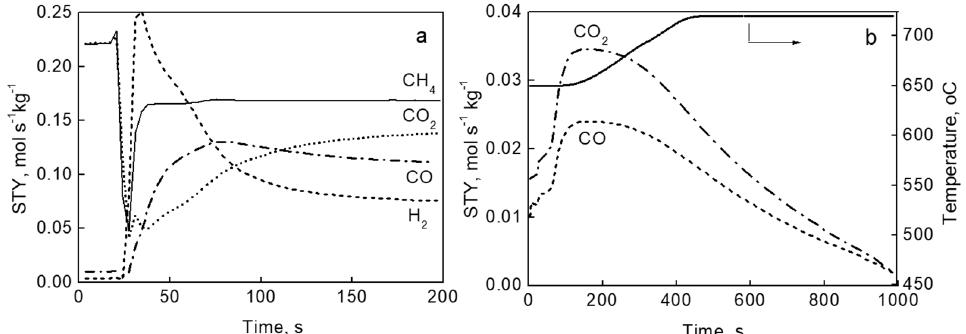
Figure 17. Space-time yield vs. time-on-stream for combined CO 2 capture and Fe 3 O 4 reduction over a NiO/Fe 2 O 3 –CeO 2 and CaO-Al 2 O 3 (1:5) mix. ( a ) CaO carbonation and Fe 3 O 4 reduction with CH 4 + CO 2 (1:1) at 650 °C, and ( b ) CaCO 3 decarbonation and CO production by iron and carbon oxidation by CO 2 . Temperature rise from 650 to 720 °C in He. Solid line: temperature profile [84]. Initially, CO 2 decreases because it gets adsorbed by CaO and consumed in dry re- forming. Once CaO is fully loaded with CO 2 , the CO 2 space-time yield increases again to